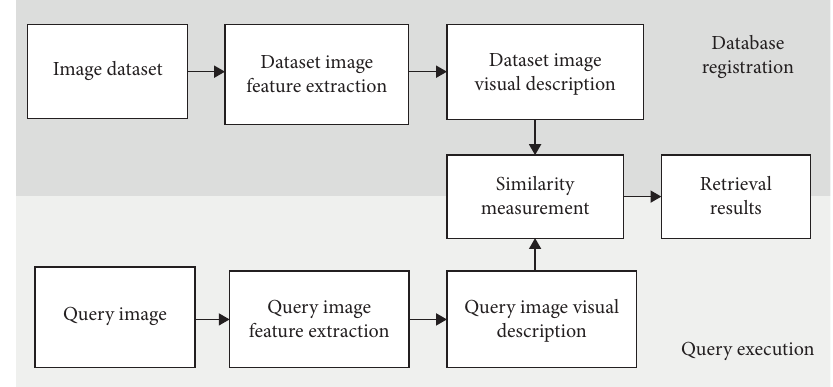
Figure 1: Block diagram of the image retrieval system based on